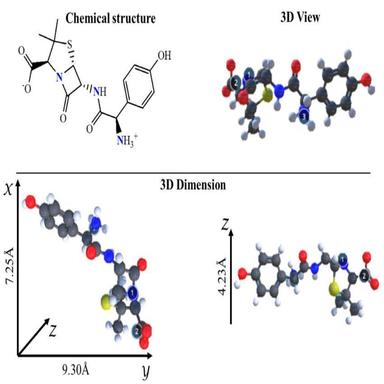
Chemical structure and size of amoxicillin molecule in it zwitterion form.